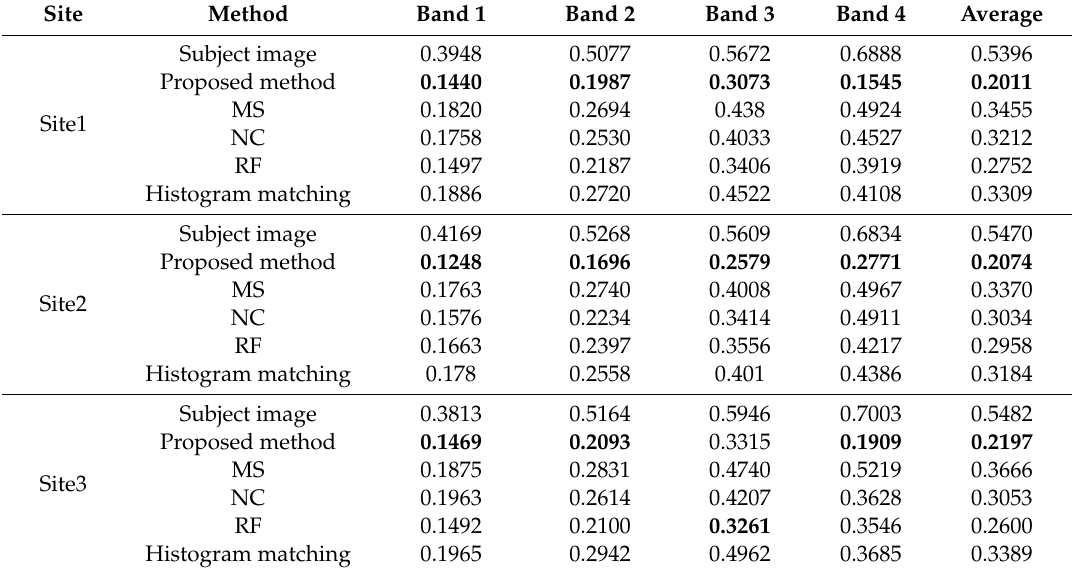
Table 3. Normalized root mean squared error (NRMSE) of relative radiometric normalization